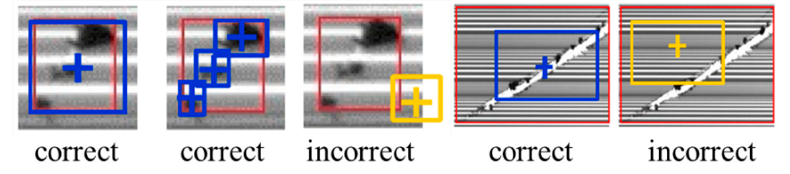
Table 3. Root sum square of FNR and FPR when T w varied from 185 to 215.